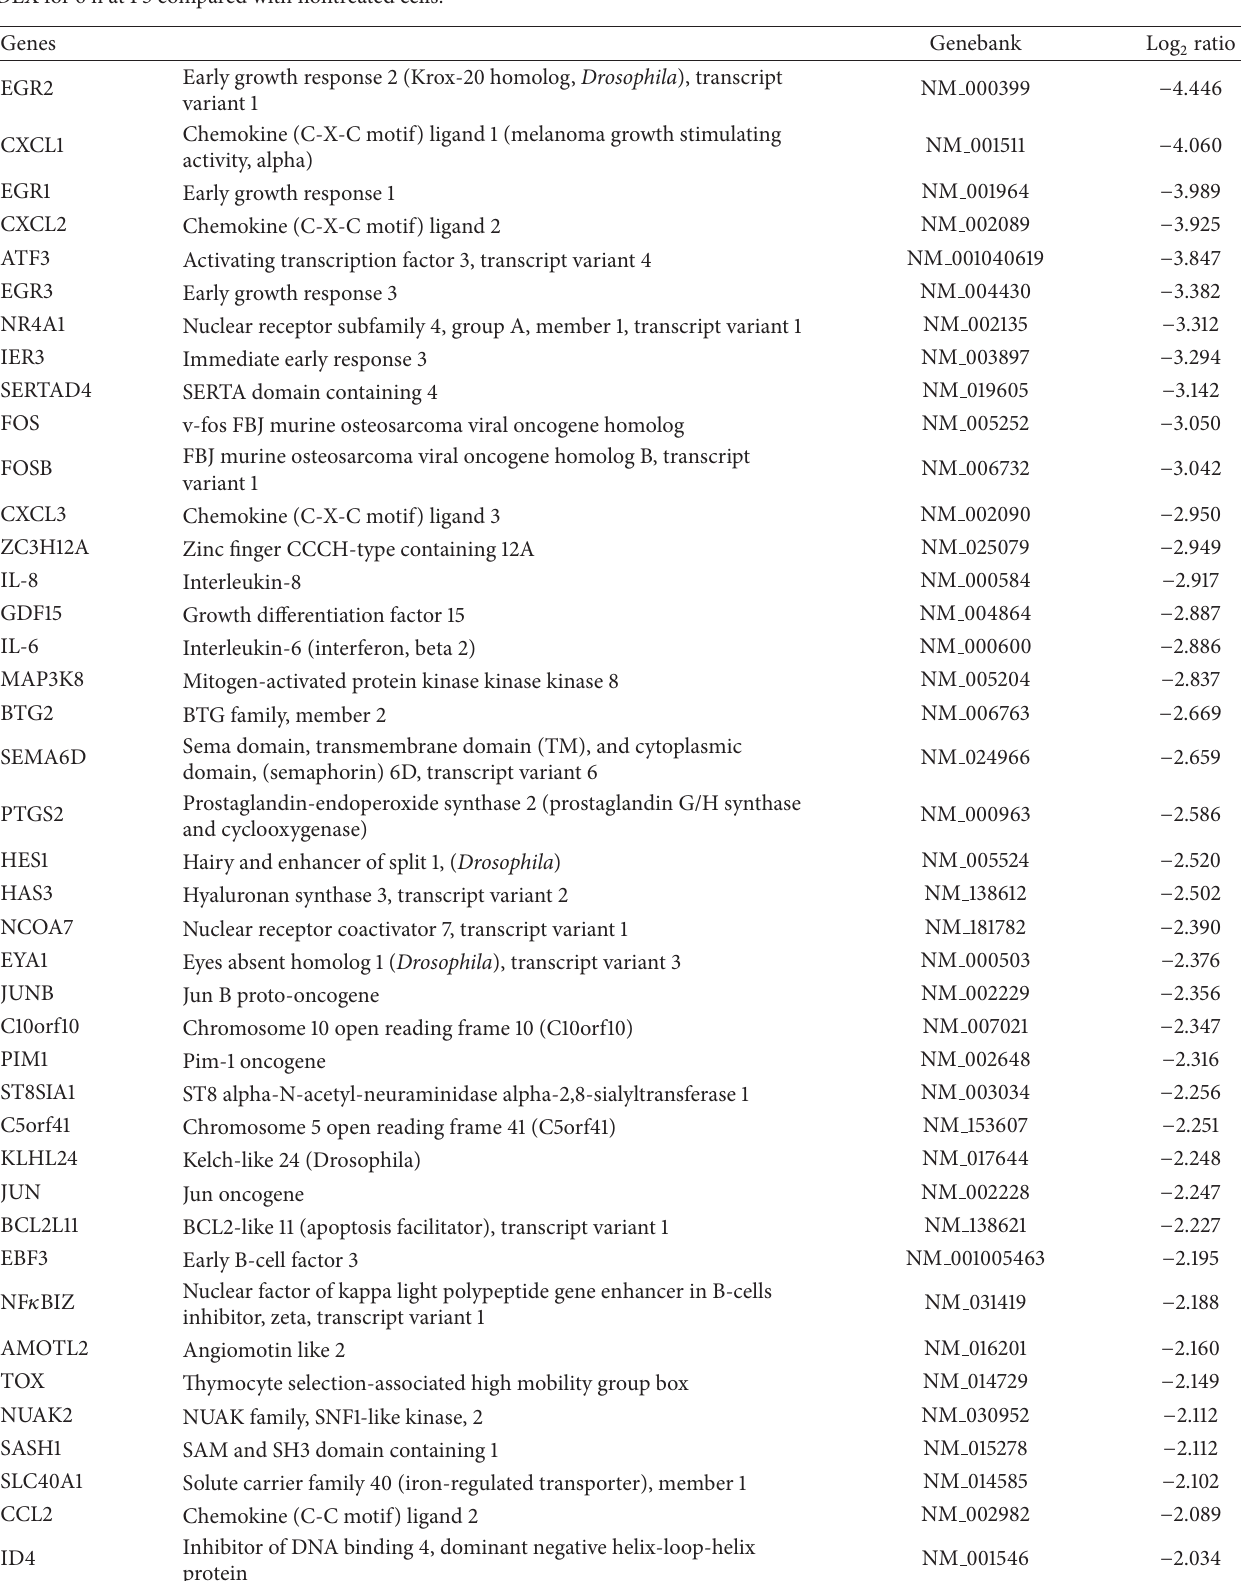
Table 3: Genes downregulated in hBMSCs by DEX treatment. Human genes downregulated by at least threefold in hBMSCs treated with DEX for 6 h at P5 compared with nontreated